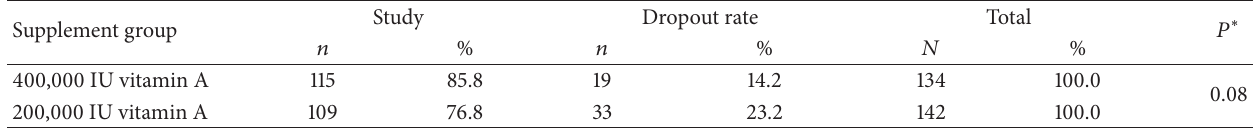
Table 2: Distribution of children dropping out by supplement group, Recife, PE, 2007/09.